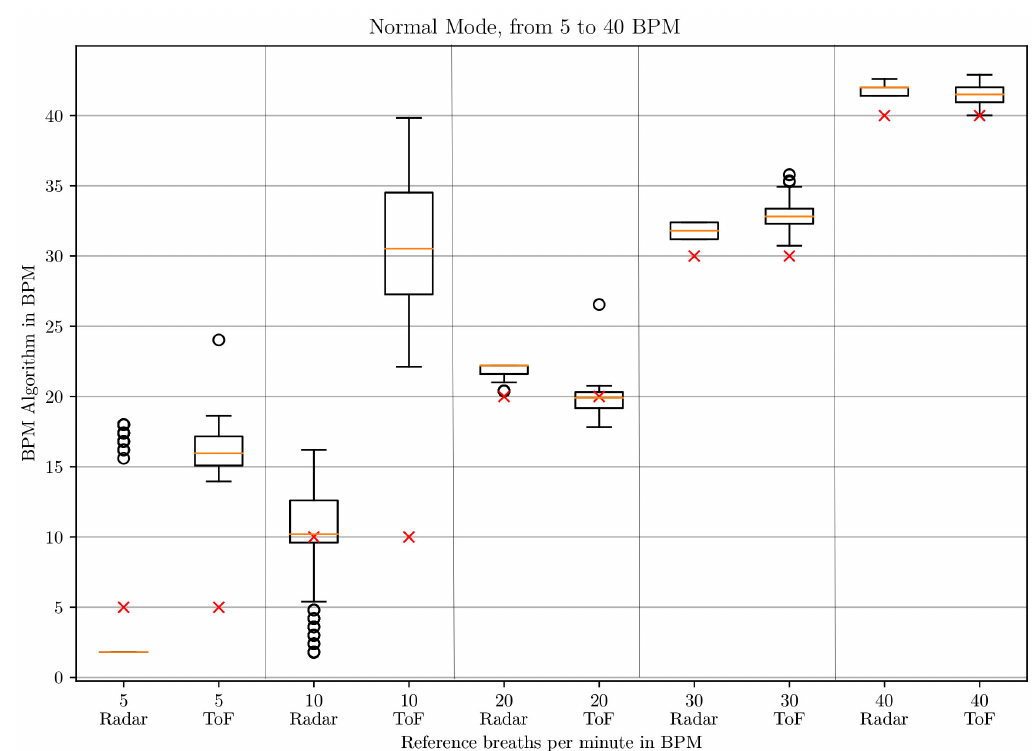
Figure 12. Box plot comparing the BPM values of the ToF and the radar algorithm for respiratory rates between 5 and 40BPM in normal mode.